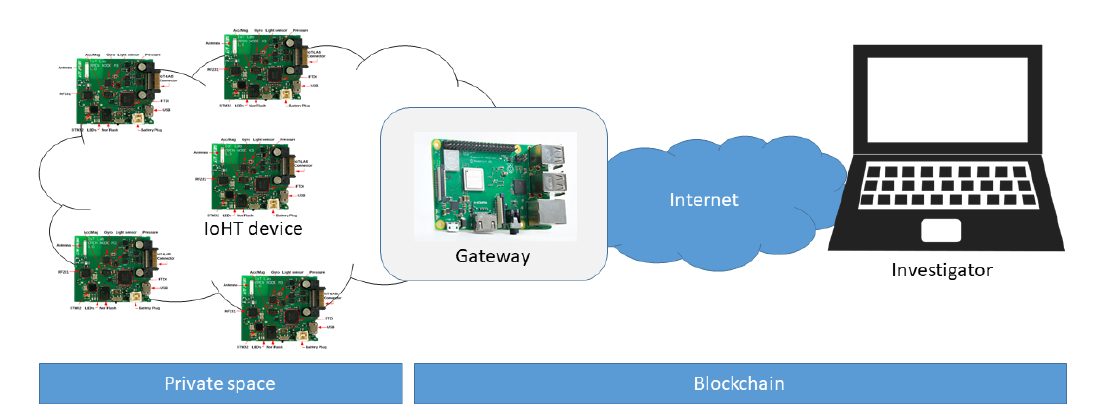
Figure 5. Experimental